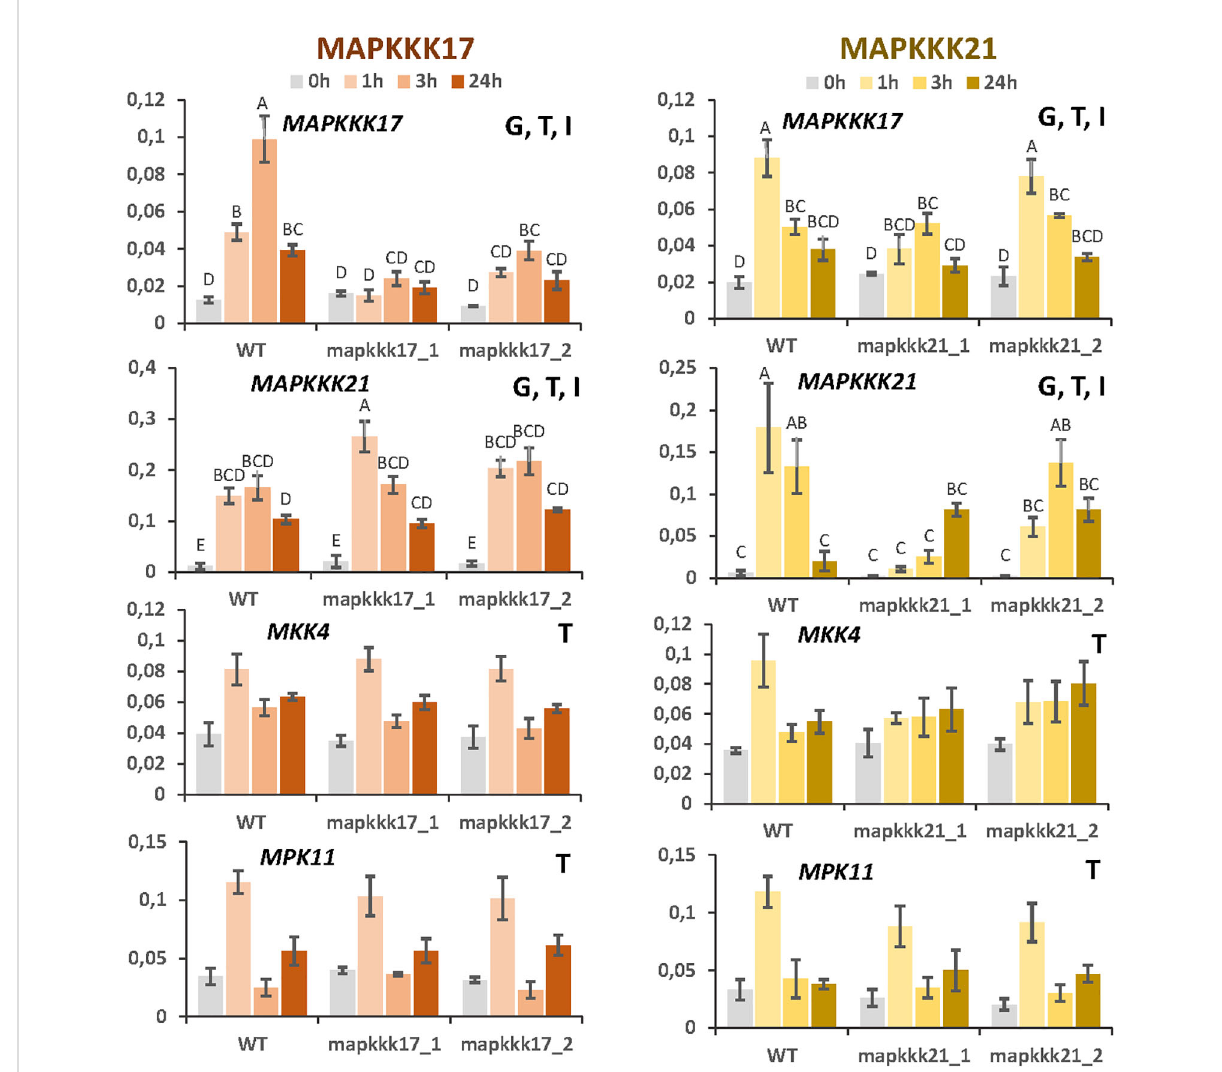
FIGURE 6 Relative expression of MAPKKK17 , MAPKKK21 , MKK4 , and MPK11 genes in different Arabidopsis backgrounds. Gene expression was quanti fi ed by RT-qPCR after 1h, 3h, and 24h of mite feeding on WT and T-DNA mutant lines. Data are means ± SE of three biological replicates. Signi fi cant factors (SF) indicate whether the two independent factors, T (treatment with mites) and G (genotype), and/or their interaction, I (T×G), were statistically signi fi cant (Two-way ANOVA, P<0.05, followed by Student-Newman-Keuls multiple comparisons test). Different letters indicate signi fi cant